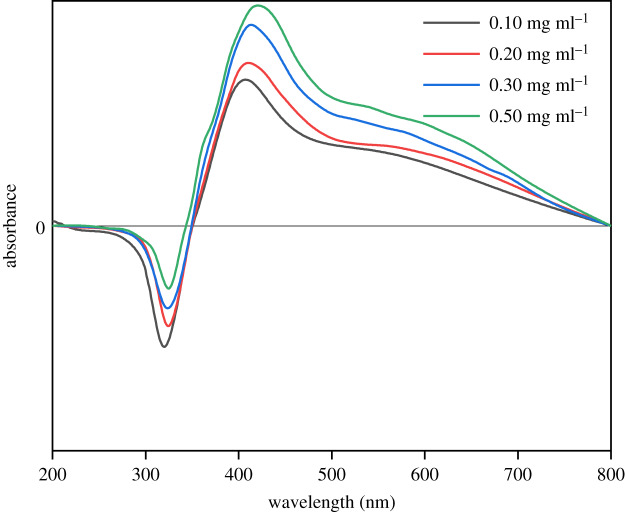
UV-visible spectra of AgNPs synthesized from AgNO3 nanoemulsion with different [AgNO3].